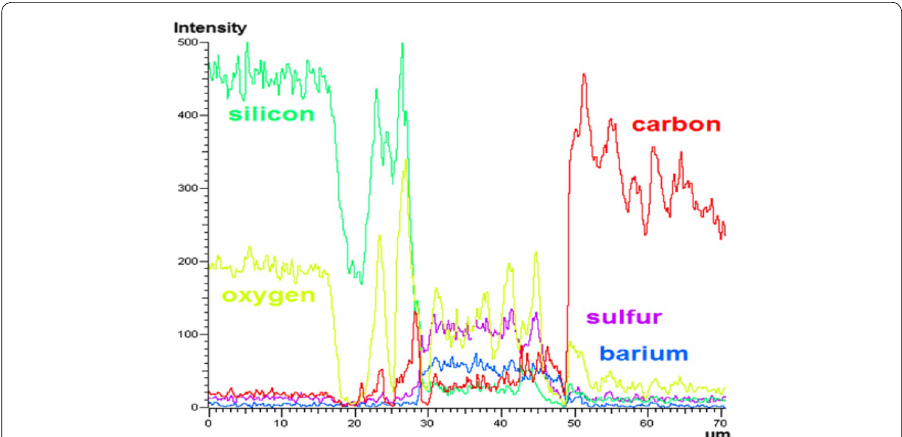
Fig. 17 Result of the line scan with concentration curves of the measured elements. For position of the line, see Fig. 16. The colored lines show the intensity of the elements (yellow-oxygen, green-silicon, red-carbon, purple-sulfur, blue-barium) over the length of the